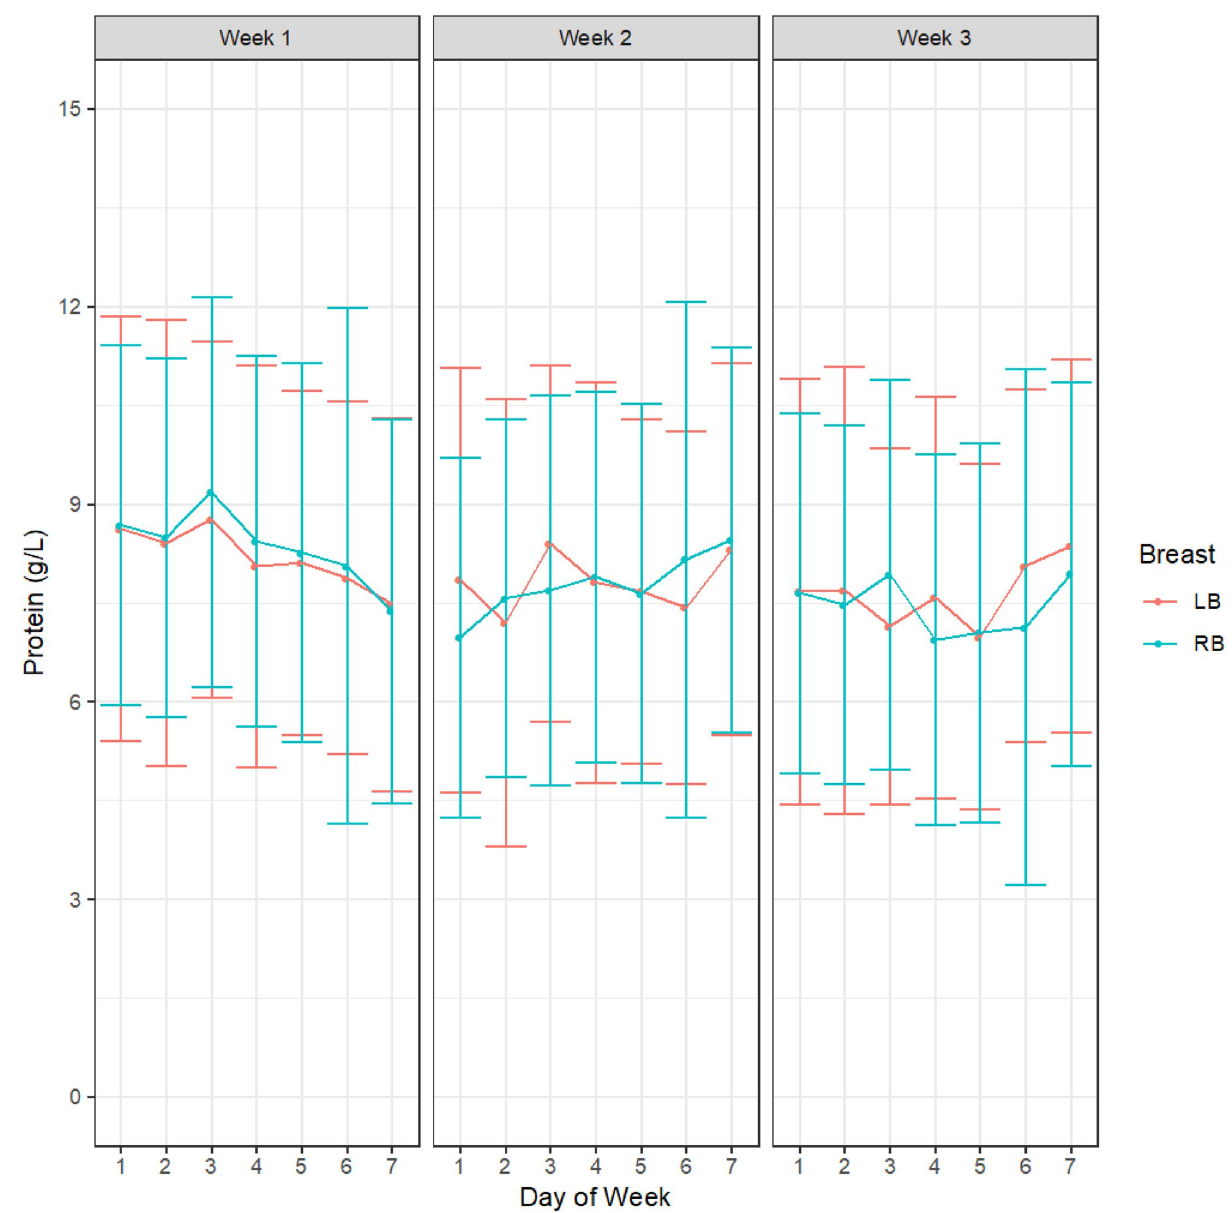
Figure 2. HM protein concentrations within participants across the days and between breasts for week 1, week 2 and week 3. Left breast (LB, red); Right breast (RB blue). Values are shown as mean and standard